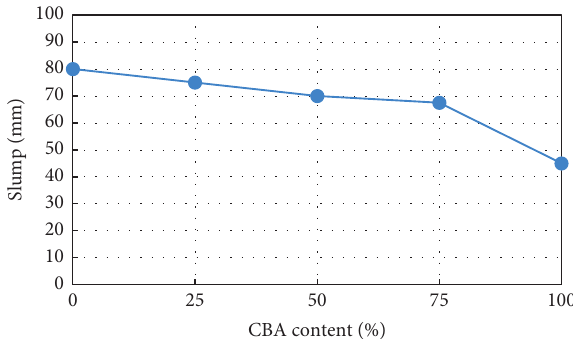
Figure 4: Effect of the CBA on the slump of the concrete.